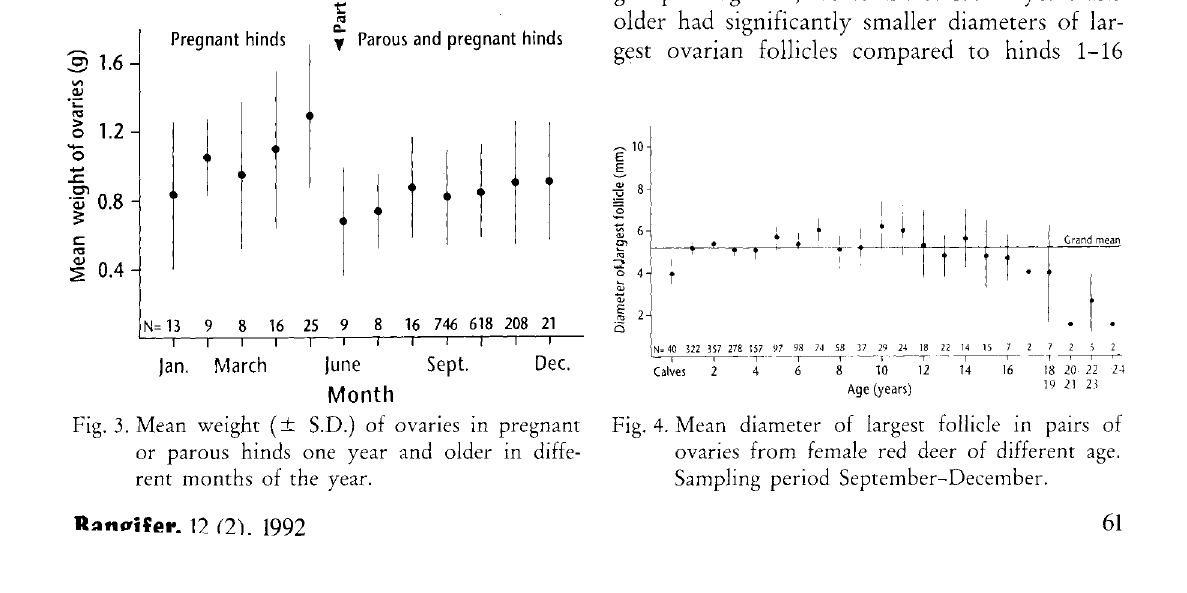
Fig. 4. Mean diameter of largest follicle in pairs of ovaries from female red deer of different